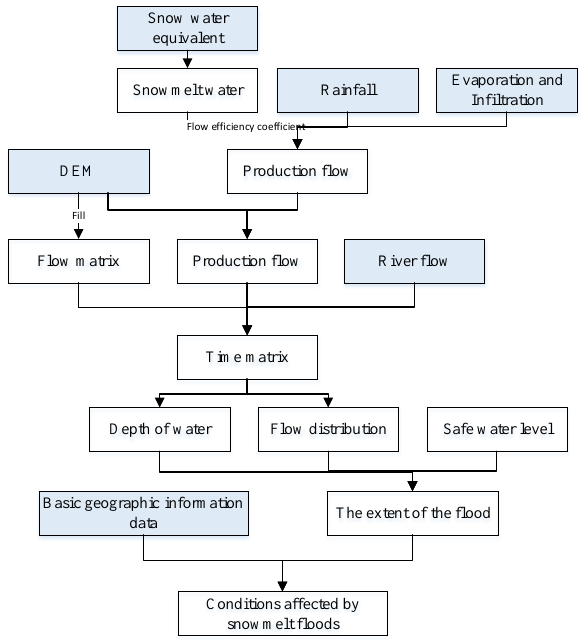
Figure 1. Technical flow chart of the